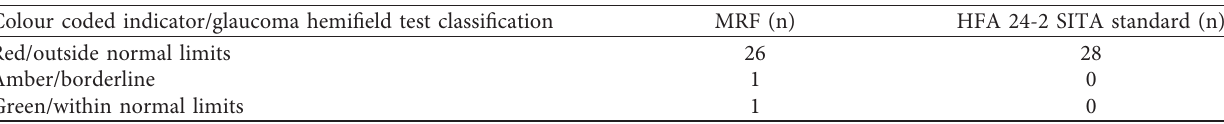
Table 2: Glaucoma hemifield test/colour coded indicator results obtained with Humphrey Field Analyzer (HFA) 24-2 Swedish Interactive Threshold Algorithm (SITA) standard and Melbourne Rapid Fields (MRF).